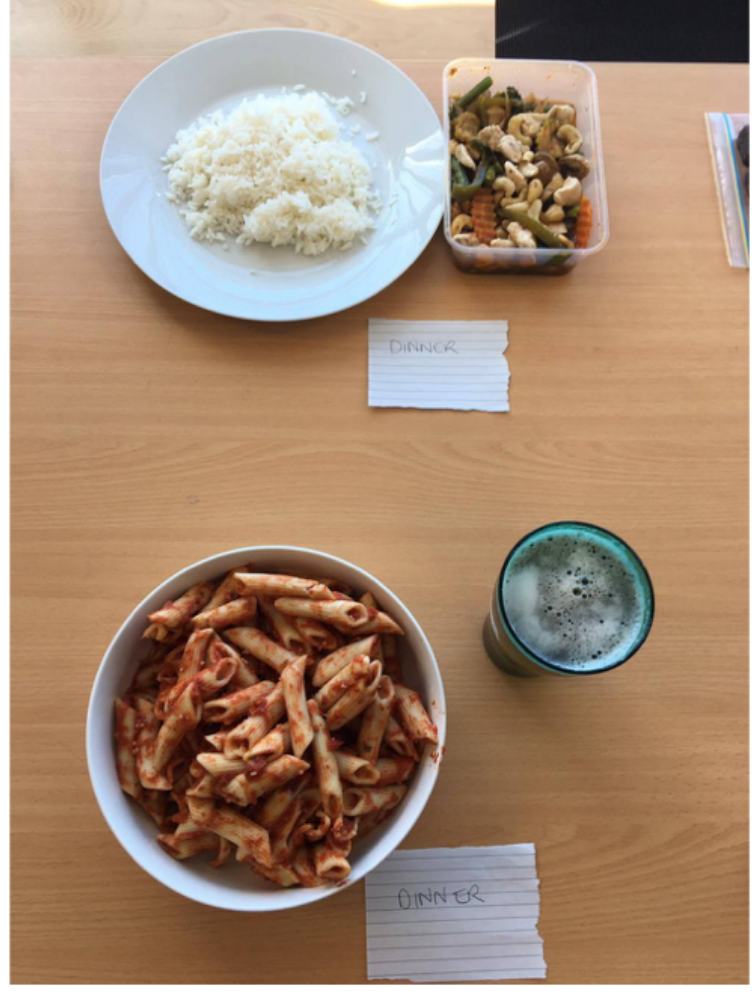
Figure 3. An example of the real foods presented to participants in Phase